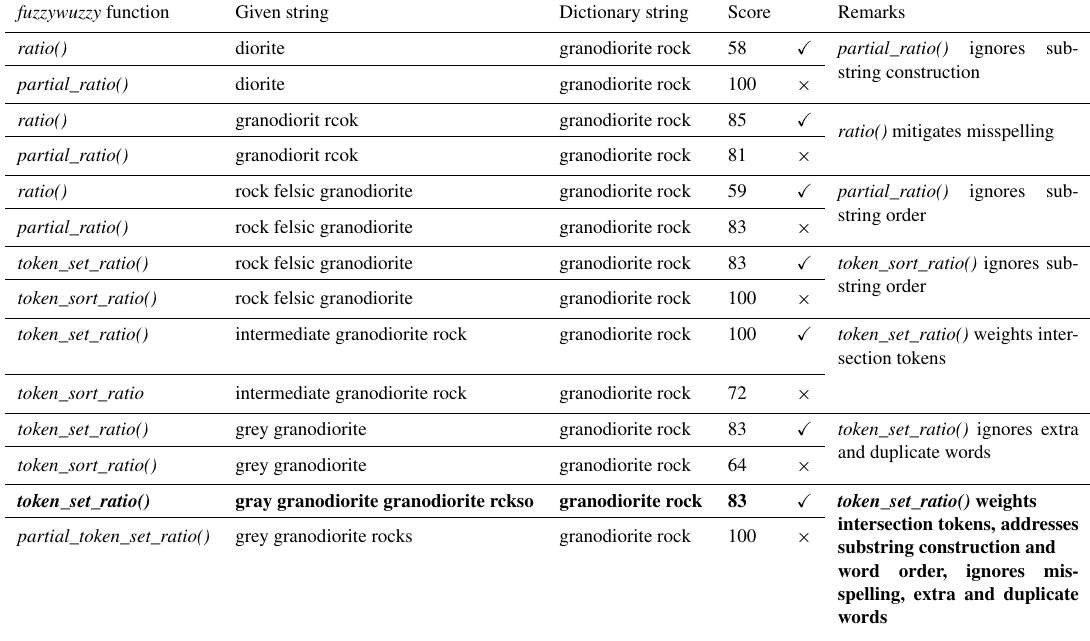
Table 1. Examples of fuzzy string matching output using different combinations of the fuzzywuzzy functions. The ticks and crosses beside the score indicate the preferred (ticks) result between the methods clustered together. The item in bold is the preferred method for this work.